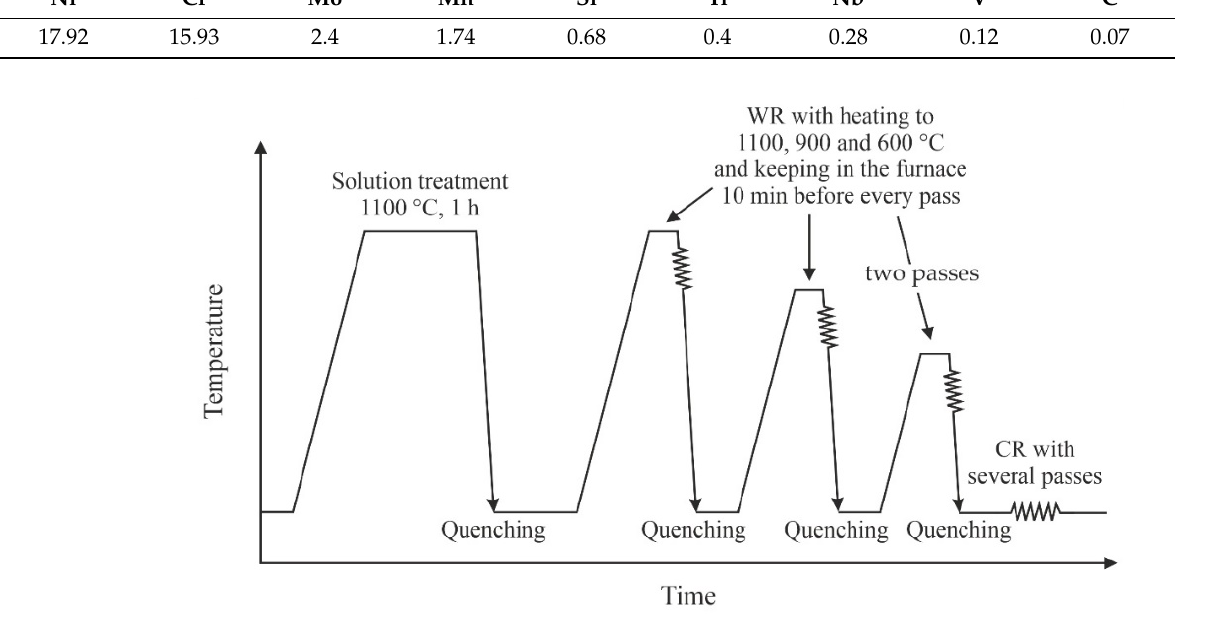
Figure 1. Scheme of multistage thermomechanical